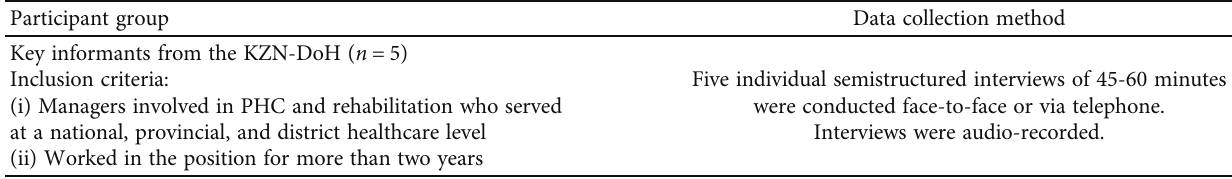
Table 1: Data collection methods, participants, and documents